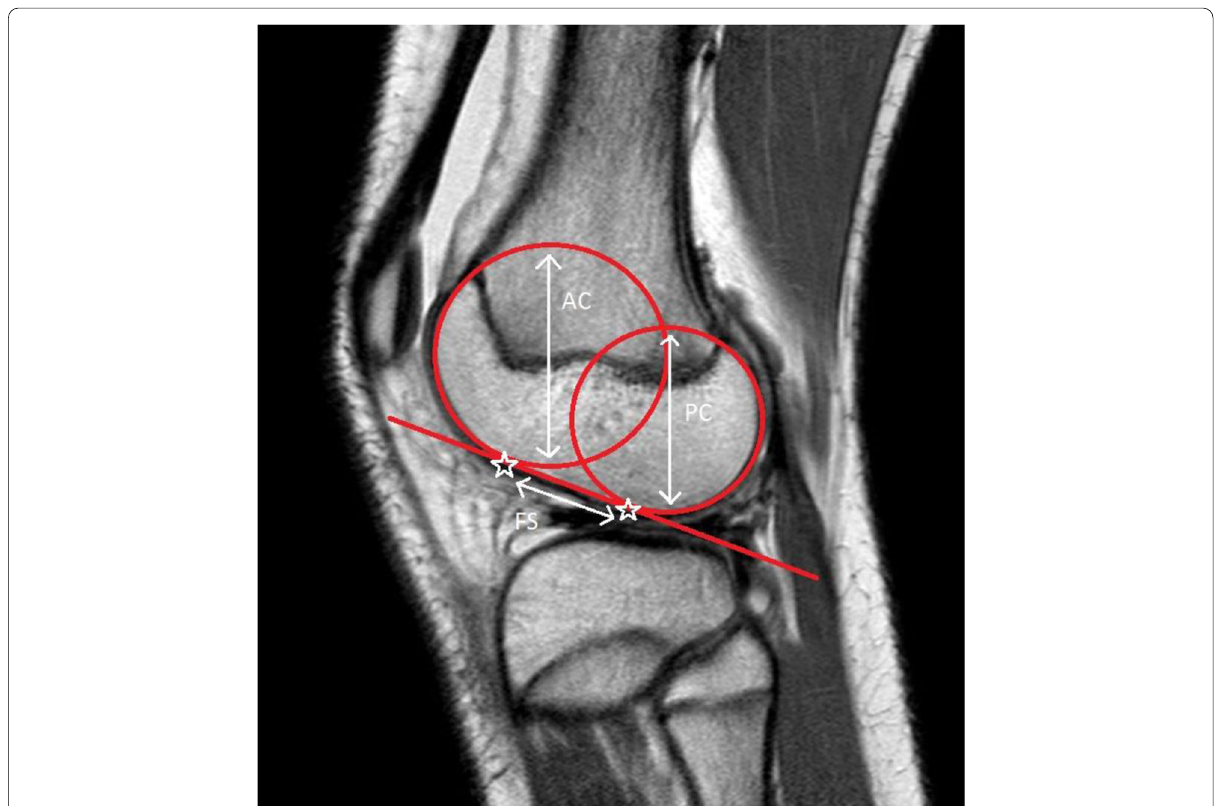
Fig. 3 MRI measurements of the femur. The anterior “extension” circle [AC] and posterior “flexion” circle [PC] are drawn [14]. A line tangent to both circles determines the flat surface [FS]